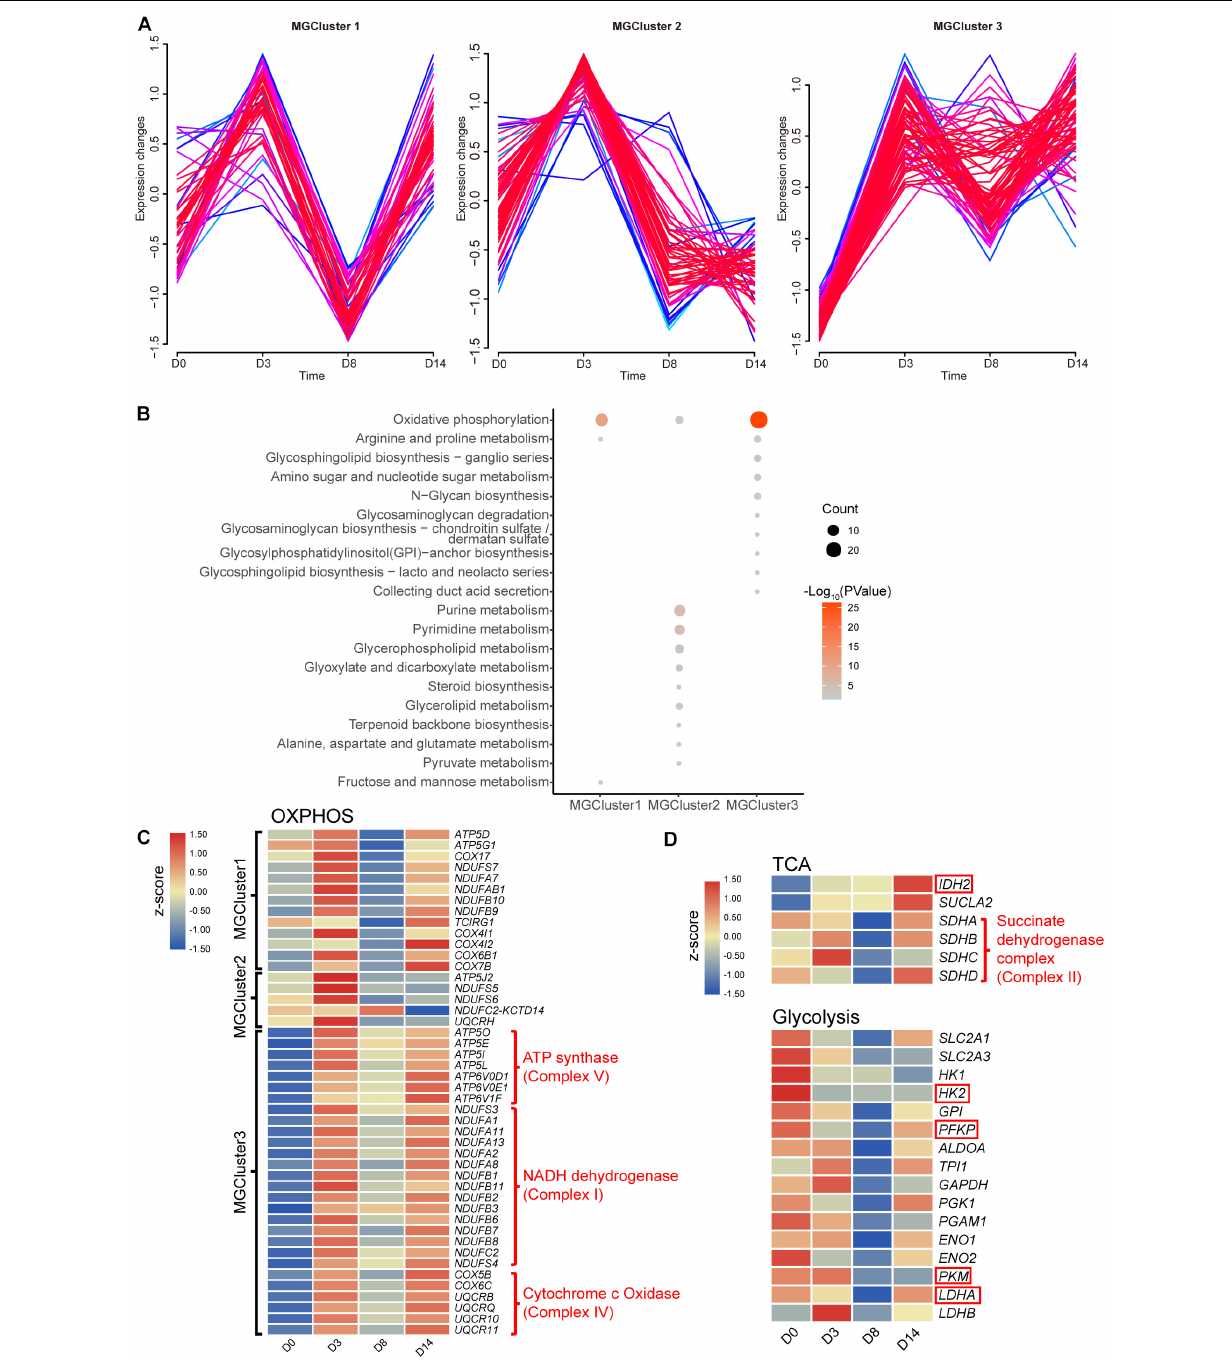
associate with a high requirement of nucleotides in the early stage of differentiation (from D0 to D3). Collectively, to a certain extent, these data demonstrated that alterations in